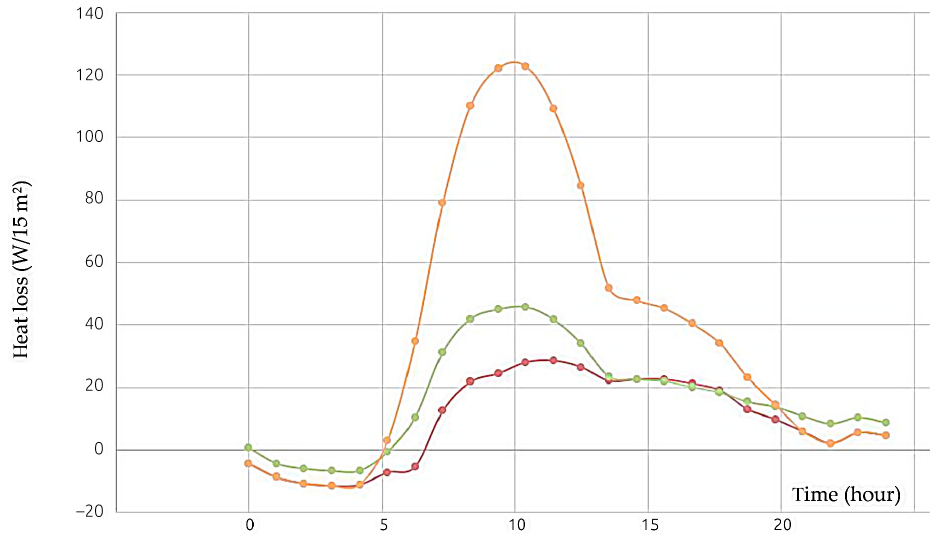
Figure 6. Example of simulated course of airflow from exterior to interior and their comparison as of 21 July 2022. Façade with traditional contact insulation system (green), façade without air flow control through a ventilated gap (red) and smart façade with airflow control through a ventilated gap (orange).